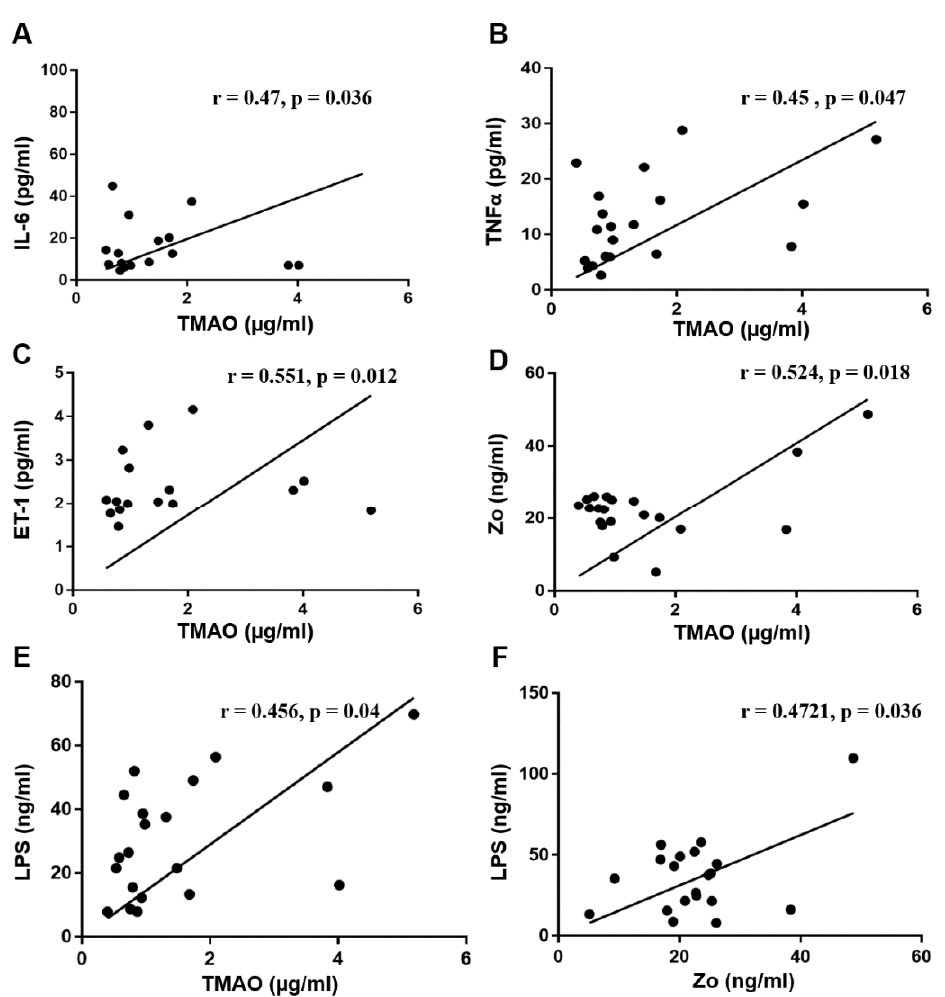
Figure 4. The positive correlation between the elevated levels of TMAO and serum biomarkers ( A – E ), and between Zo and LPS ( F ) in the serum of T2DM-CKD patients.